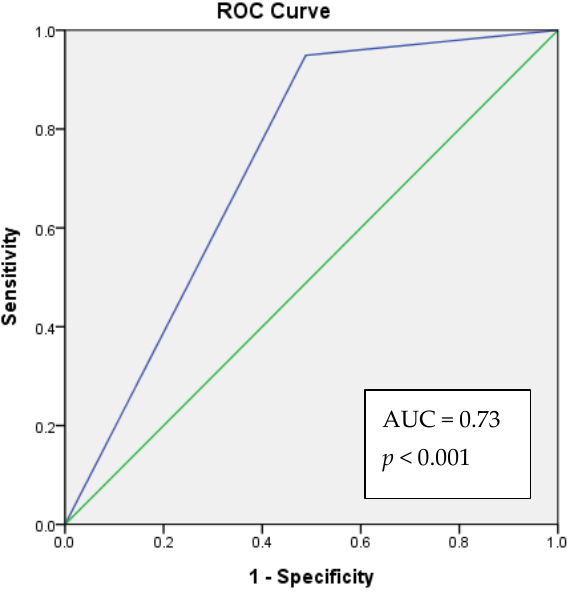
Figure 2. The receiver operating characteristic (ROC) curve analysis of the lack of salivary XIST expression to morbidity prediction of OSCC. Blue line: XIST expression. Green line: reference. A patient who lacks salivary XIST expression will have a higher predicted OSCC risk score than a patient with salivary XIST expression. The model will correctly assign a higher absolute OSCC risk to a patient with an absence of XIST expression 73% (acceptable dis ‐ crimination) of the time.